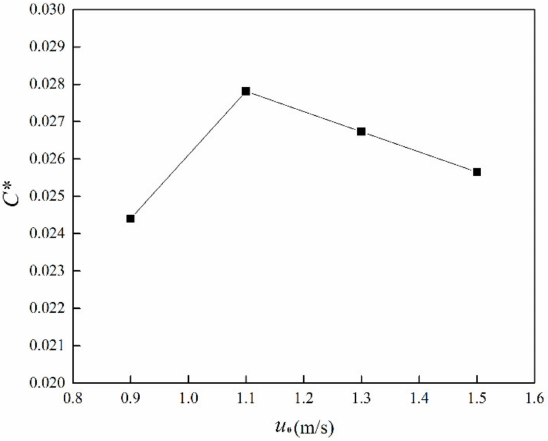
Figure 23. Relative concentration per unit area C* on the vertical plane (y = 0) of the typical ideal street with different characteristic wind